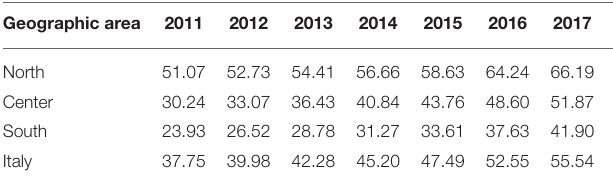
TABLE 1 | Percentage recycling urban waste (Source: ISPRA). Geographic area 2011